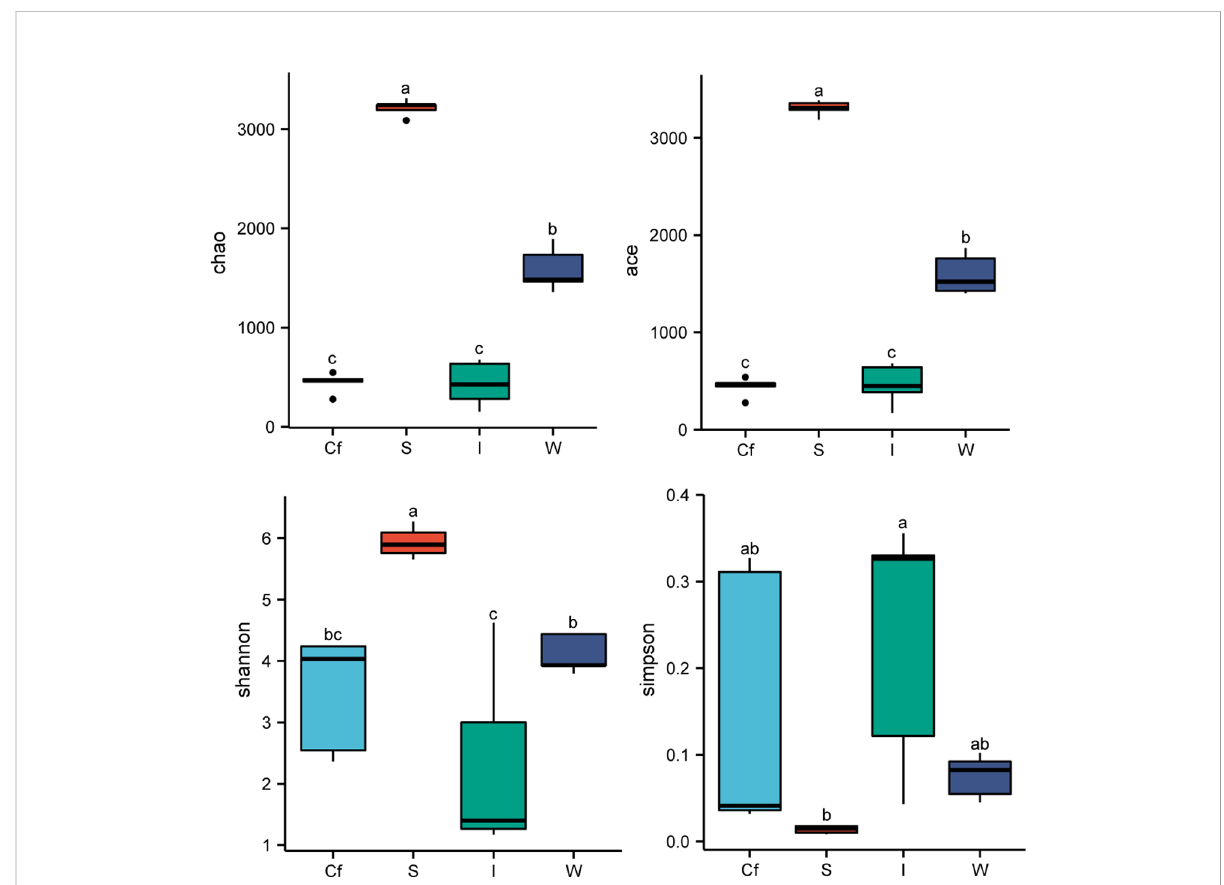
FIGURE 3 Alpha diversity index of water (W), sediments (S), coelomic fl uid (Cf) and intestine (I) of S. nudus . Means with the same letters are not signi fi cantly different ( P > 0.05).